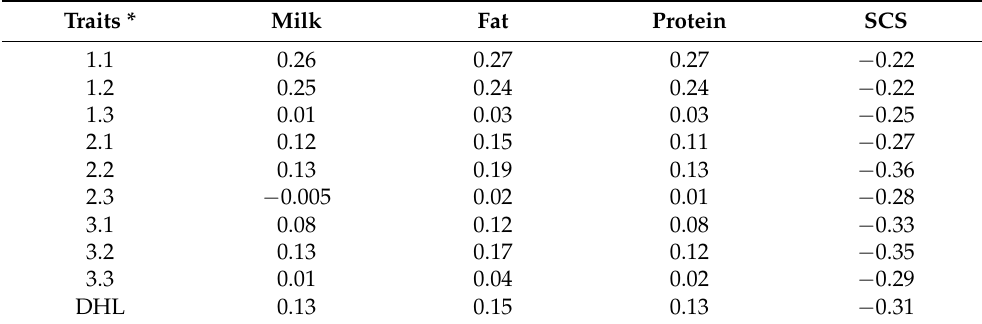
Table 5. Breeding value correlations among the milk production traits and sires’ direct herd life for Korean Holsteins. Traits *